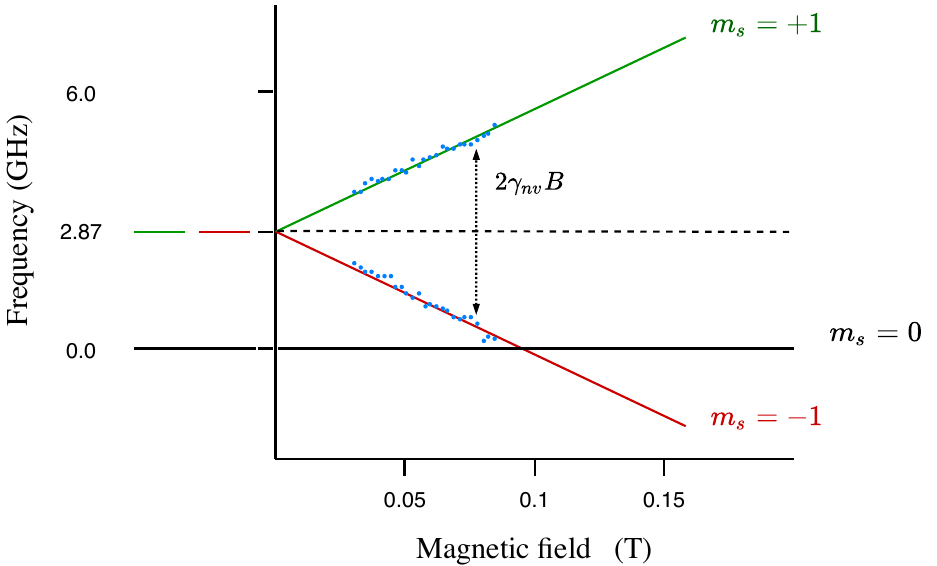
Figure 8. Zeeman splitting of the degenerated state under the effect of an external magnetic field B and experimental results (blue dots), observed for a bulk sample in the direction of the magnetic field in the crystallographic direction (other directions are also represented in Figures 9 and 10). The energy splitting of the states m s = + 1 and m s = − 1 (green and red lines) is 2 γ e B, linear and proportional to B with 2 γ the gyromagnetic ratio of the NV center. The zero splitting happens at the resonance frequency of 2.87 GHz. When the magnetic field reaches 0.1 T for the ground state and 0.05 T for the excited state, and then, due to the ground or excited state level anticrossing, the m s = 0 and m s = − 1 states become equal in